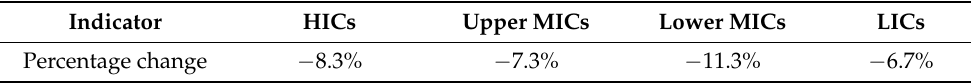
Table 5. Percentage change in working hours in 2020 compared to